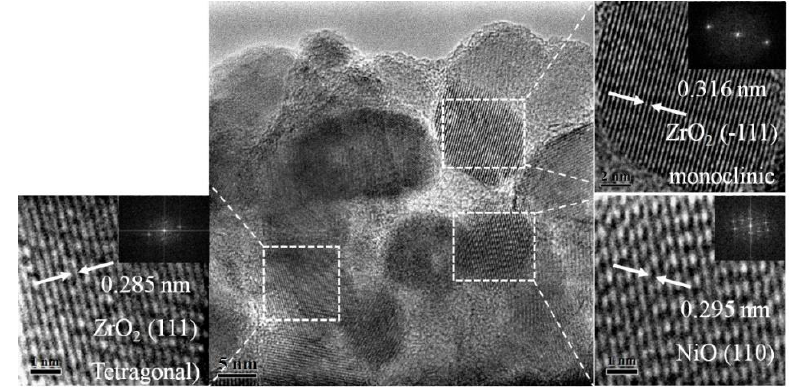
Figure 8. TEM and HRTEM images of a 20% Ni/ZrO 2COP-S catalyst. The white arrows correspond to the reflections. The inset shows the diffraction pattern showing these reflections.